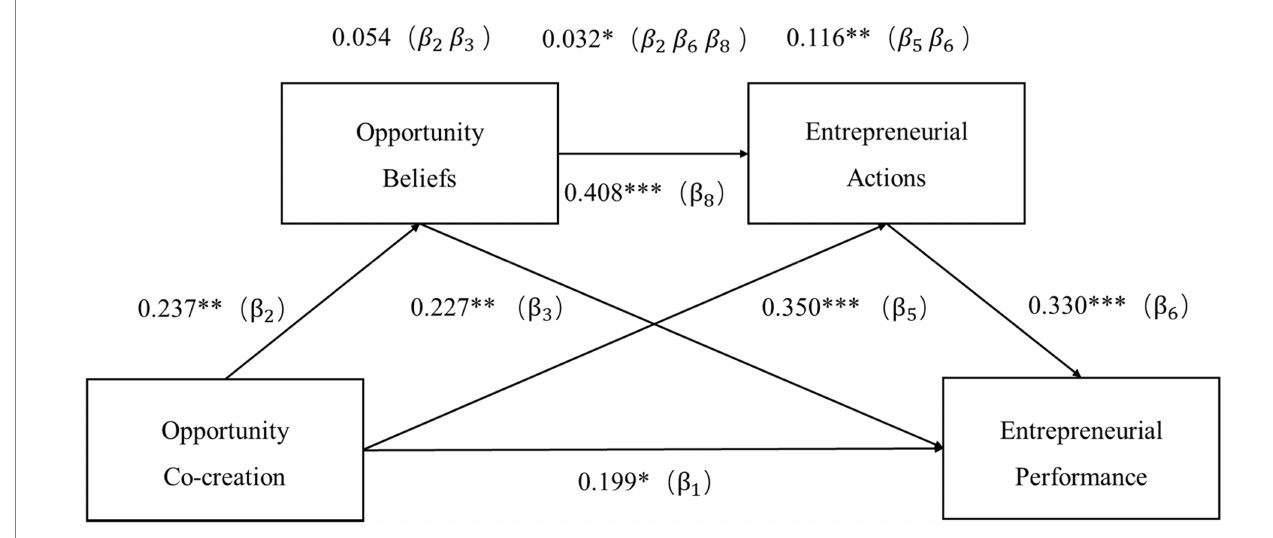
FIGURE 2 The output of the hypothesis model. Italics indicate mediating effects. * p < 0.05, ** p < 0.01, and *** p < 0.001.